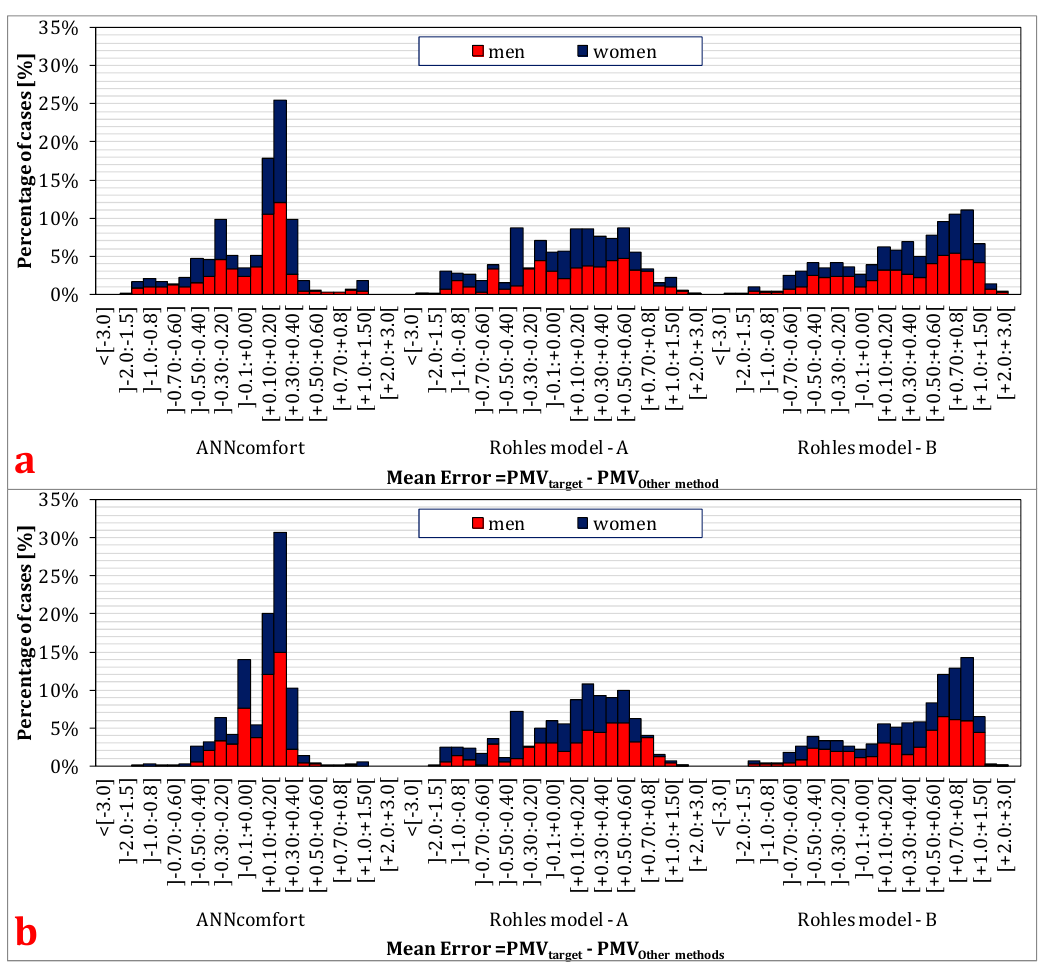
Figure 9. Mean error range comparison: ( a ) related to range δ SD1 and ( b ) related to range δ SD2 .